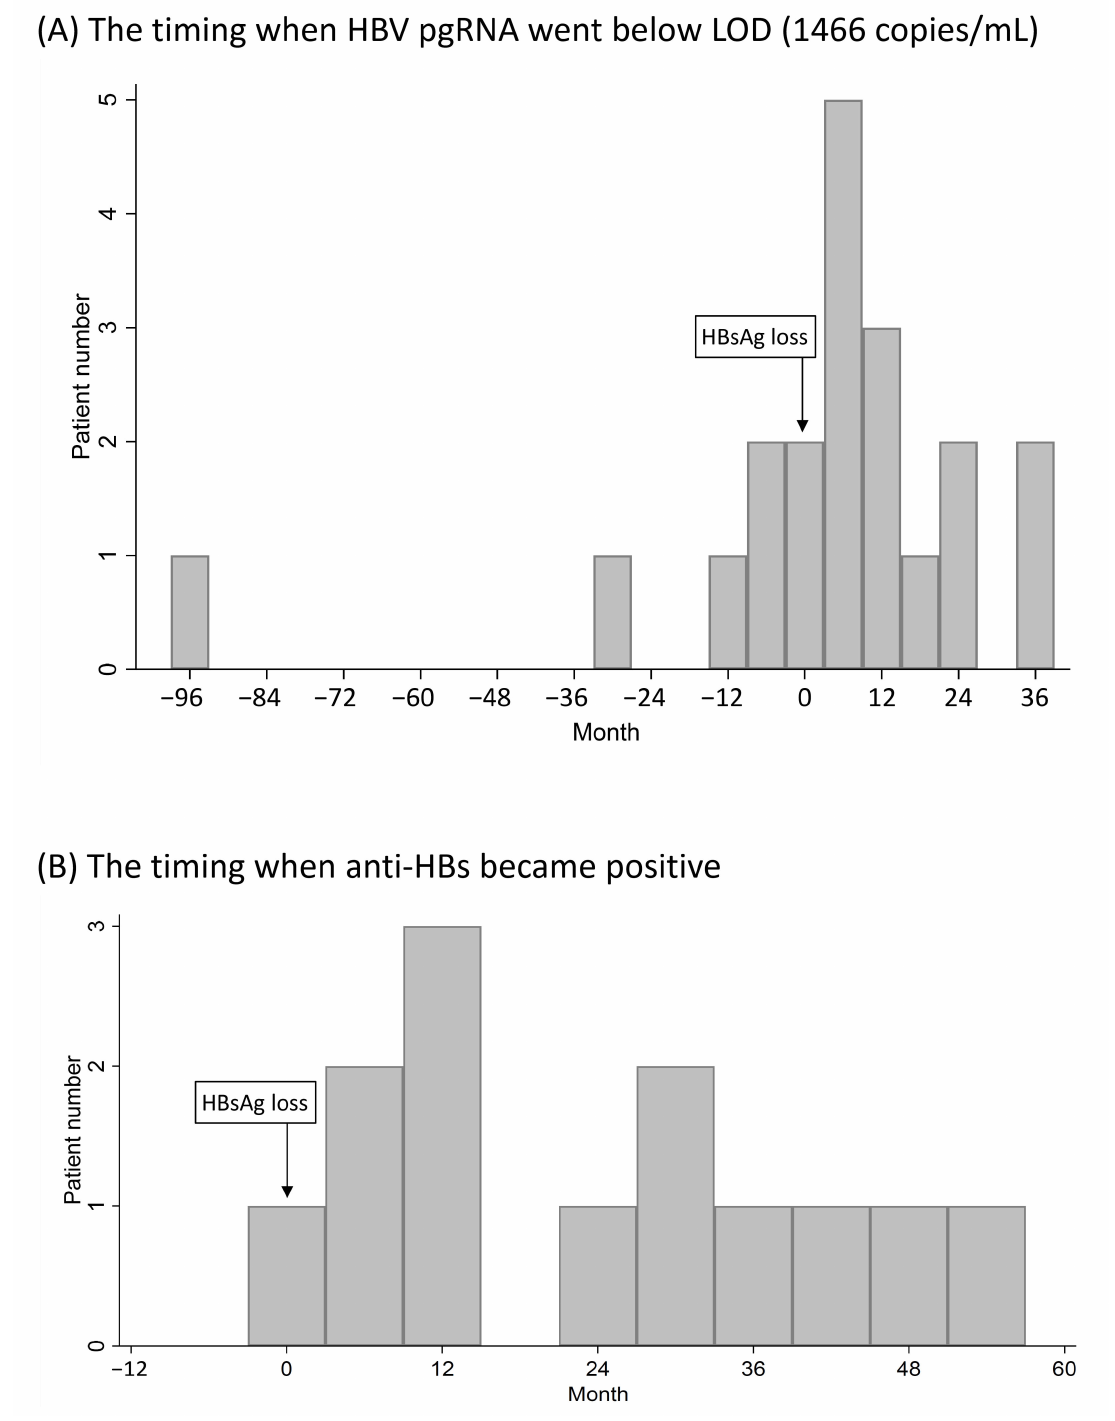
Figure 6. The timings when HBV pgRNA went below LOD (1466 copies/mL) ( A ) and anti-HBs became positive ( B ) in chronic hepatitis B patients who achieved HBsAg loss after nucleos(t)ide analogue